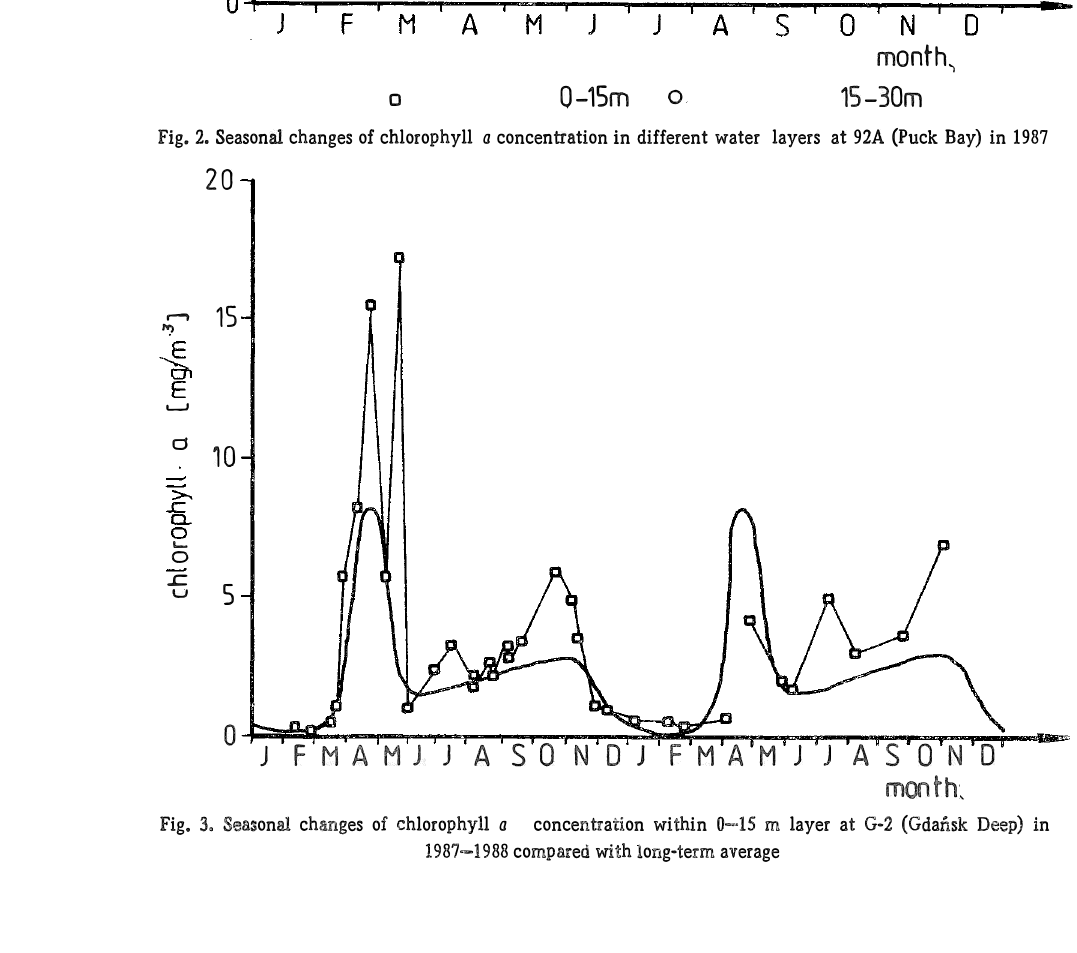
Fig. 3, Seasonal. changes of chlorophyll a concentration within 0-15 m layer at G-2 (Gdansk Deep) in 1987-1988 compared with long-term